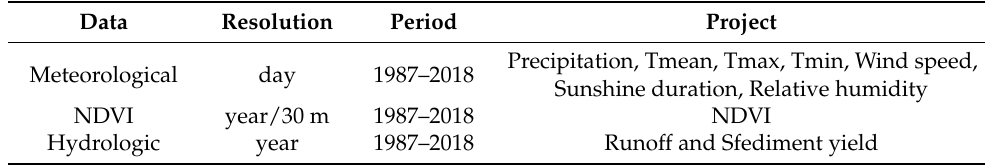
Table 1. Data and